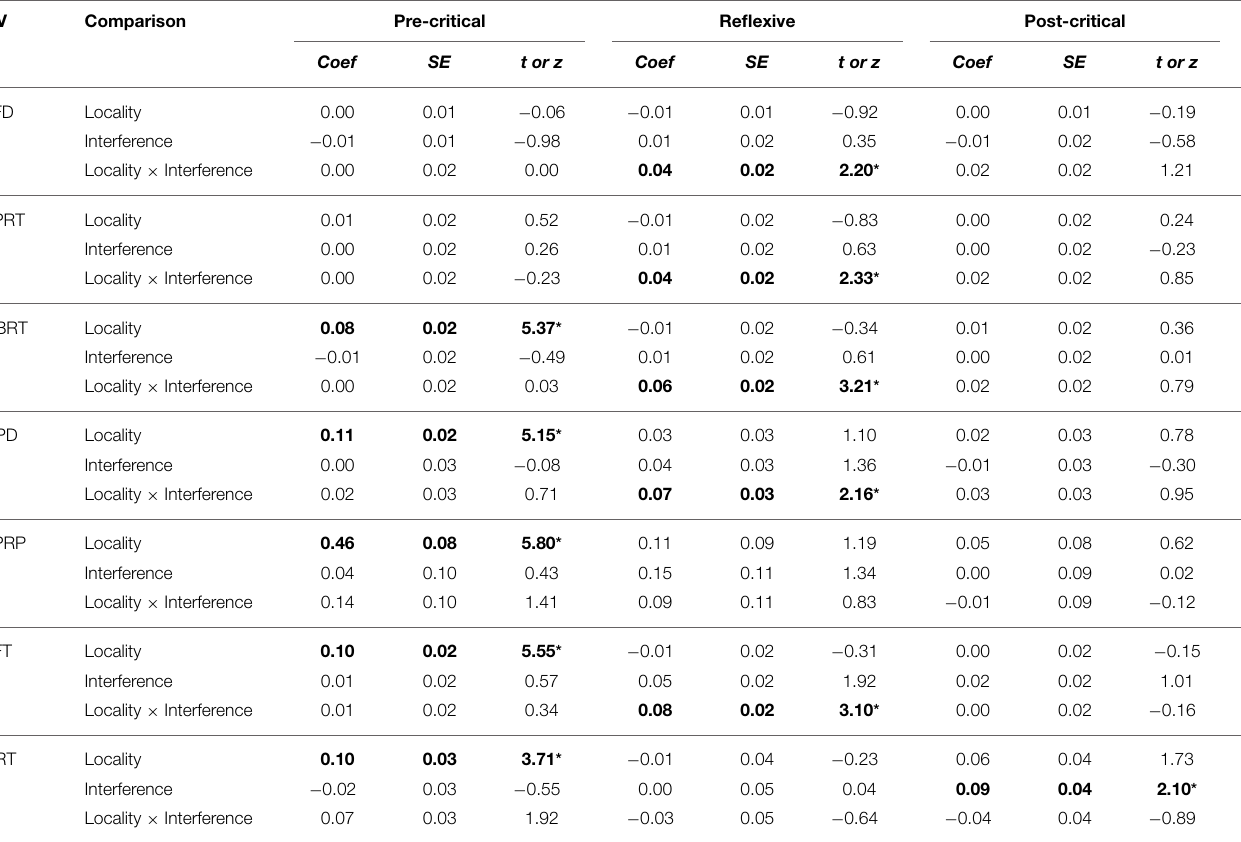
TABLE 9 | Experiment 2: Main effects of locality and interference and their interaction at the pre-critical ( ziji − 1), critical ( ziji ), and post-critical ( ziji + 1) regions for the dependent variables (DVs) first-fixation duration, first-pass reading time, right-bounded reading time, regression-path duration, first-pass regression probability, total fixation time, and re-reading